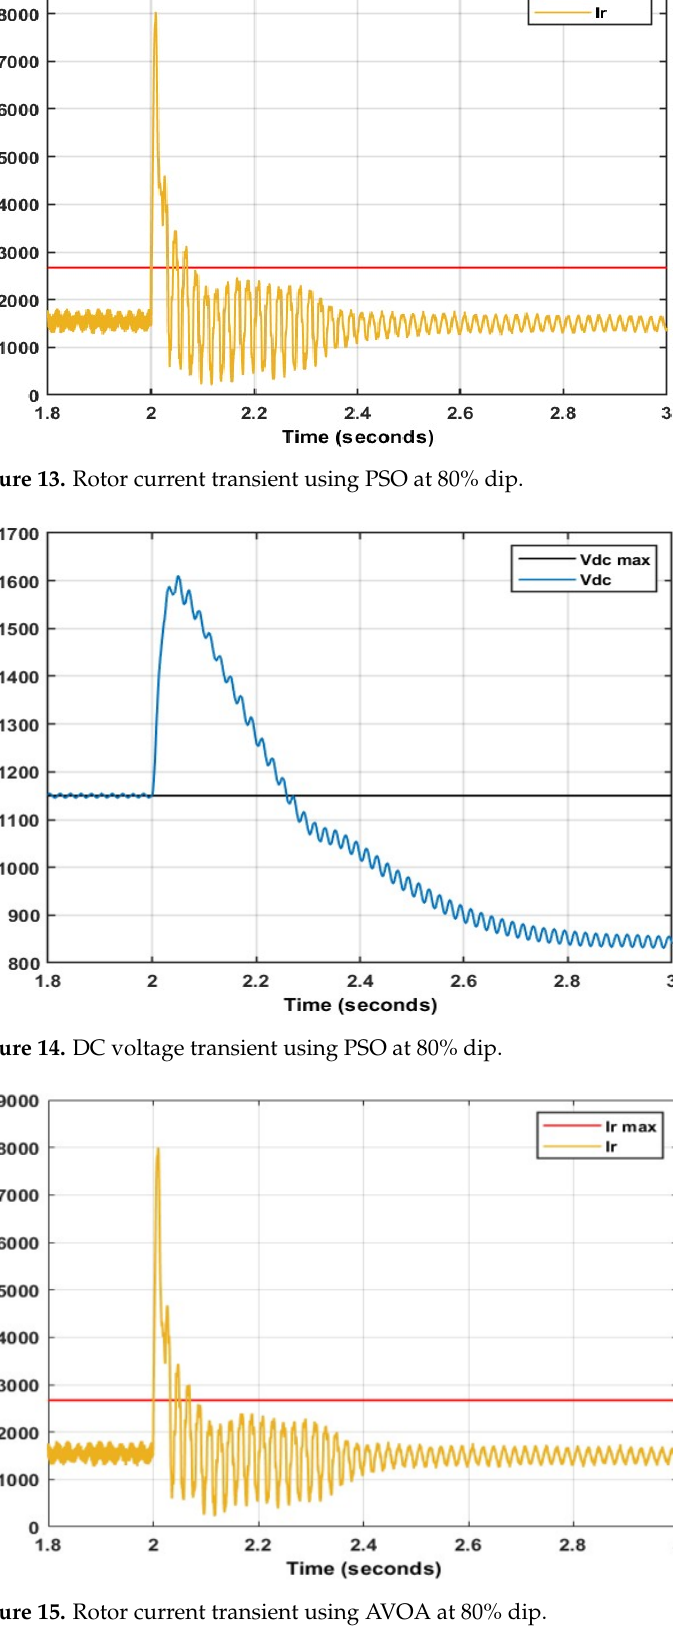
Figure 15. Rotor current transient using AVOA at 80% dip.